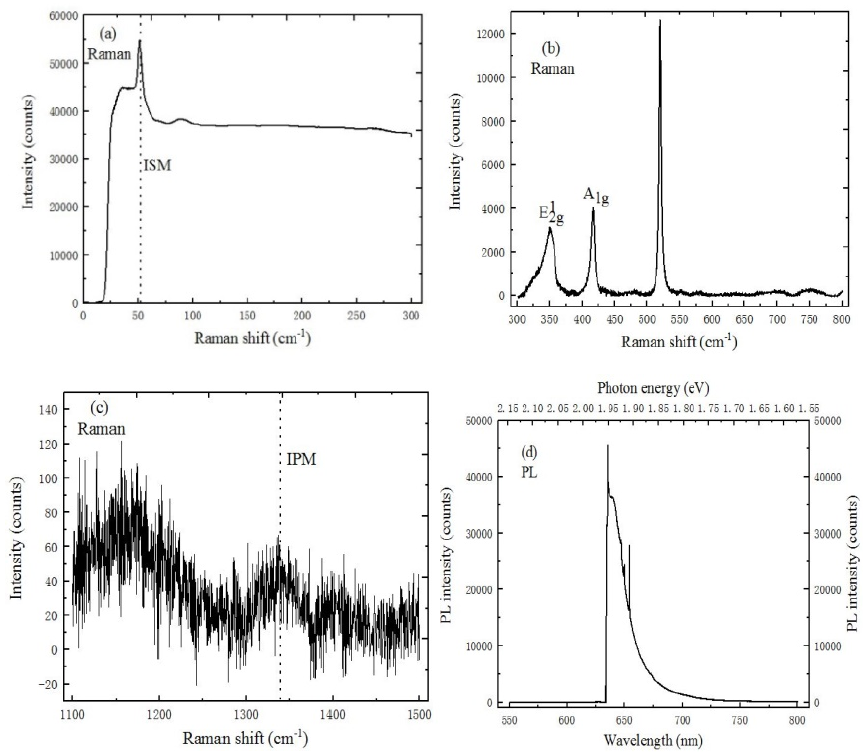
Figure 8. Spectral characteristics of WS 2 /h-BN heterostructure. ( a ) ISM mode characteristic peak of h-BN (10 mW, 633 nm), ( b ) E 1 2g and A 1g mode characteristic peaks of WS 2 (10 mW, 633 nm), ( c ) IPM mode characteristic peak of h-BN (10 mW, 633 nm), ( d ) PL spectrum of WS 2 /h-BN heterostructure (20 mW, 633